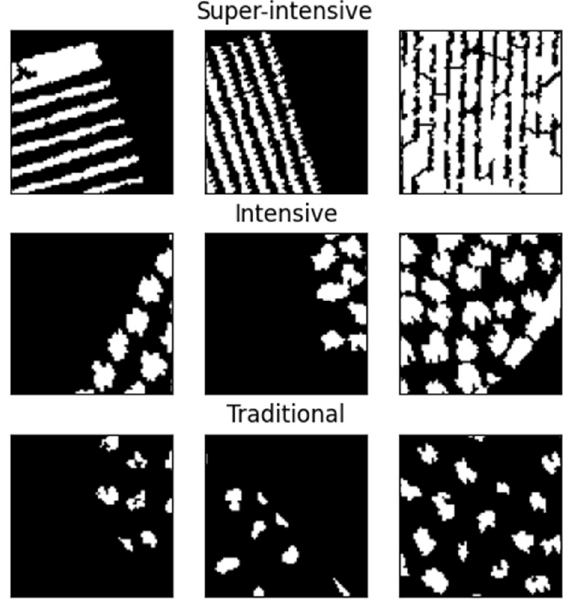
Figure 7. Examples of different mini-crops of 80 × 80 pixels from an arbitrary orchard.